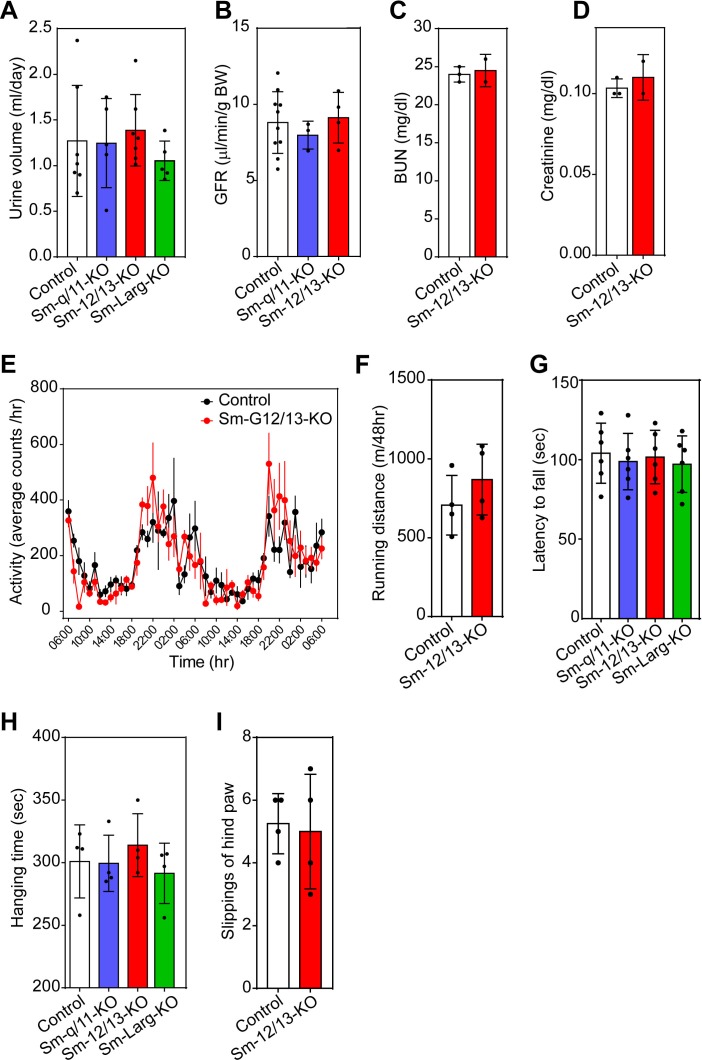
Effect of vascular smooth muscle-specific Gα12/Gα13 deficiency on Kidney and brain function.(A–D) Urine volume. (A), glomerular filtration rate (GFR) (B), blood urea nitrogen (BUN) (C) and plasma creatinine levels (D) in wild-type and the indicated mutant mice (n = 7 mice (control and Sm-12/13-KO in A), n = 5 mice (Sm-q/11-KO and Sm-Larg-KO in A), n = 10 mice (control in B), n = 3 mice (Sm-q/11-KO in B and control in C and D), n = 4 mice (Sm-12/13-KO in B), n = 2 mice (Sm-12/13-KO in C and D)). (E–I) day and night activity (E), running distance (F), rotarod analysis (G), mesh grip analysis (H) and beam cross test (I) in wild-type and the indicated mutant mice (n = 4 mice (control and mutant mice in E,F,H and I), n = 4 mice (control and mutant mice in G)). All values are mean values ± SEM. n.s. = non significant (student’s t-test (A–D, F–I) and 2-way ANOVA and Bonferroni’s post-hoc test (E).